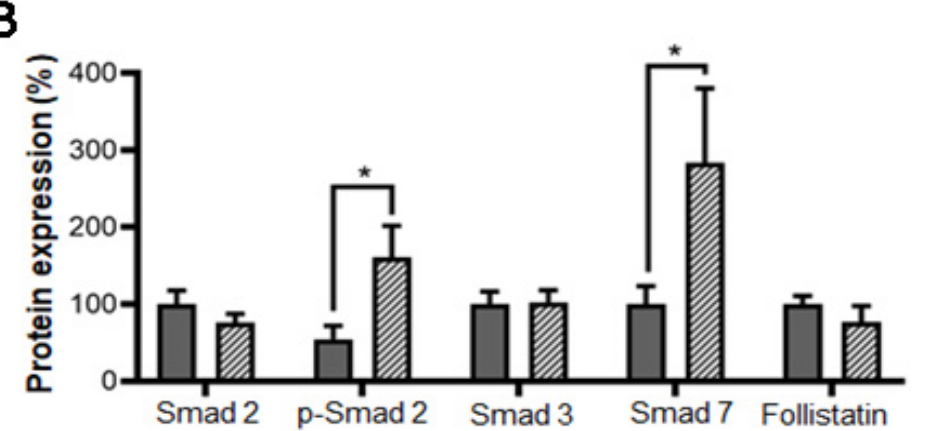
Figure 5. Myostatin signaling pathway expression in control and ESLUTD hSMCs. ( A ) The relative gene expression of myostatin and its signaling pathway Smad 2, Smad 7, follistatin and ACTRIIB in control and ESLUTD hSMCs analyzed by real-time PCR. Bars represent mean ± SEM, n = 4, repeated two times in triplicate. Data analysis by unpaired t -tests. ( B ) Protein analysis of myostatin (48 kDa), its pathway proteins Smad 2 (62 kDa), p-Smad 2 (62 kDa), Smad 3 (40 kDa), Smad 7 (48 kDa) and follistatin (48 kDa) analyzed by Simple Western. Bars represent mean ± SEM, n = 5 control and n = 4 ESLUTD samples (in duplicates) were normalized to control taken as 100%. Data analysis by unpaired t -tests. * p ≤ 0.05.